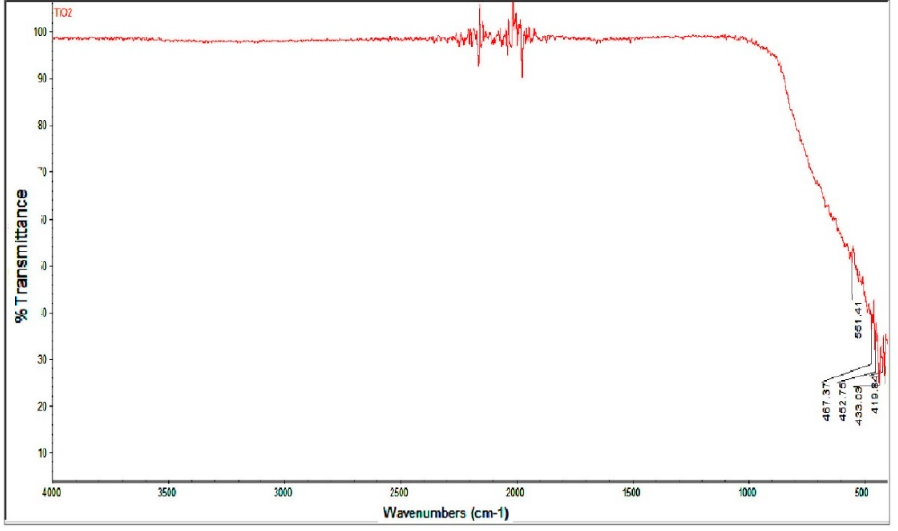
Figure 1. FT-IR of synthesized TiO 2 -NPs.